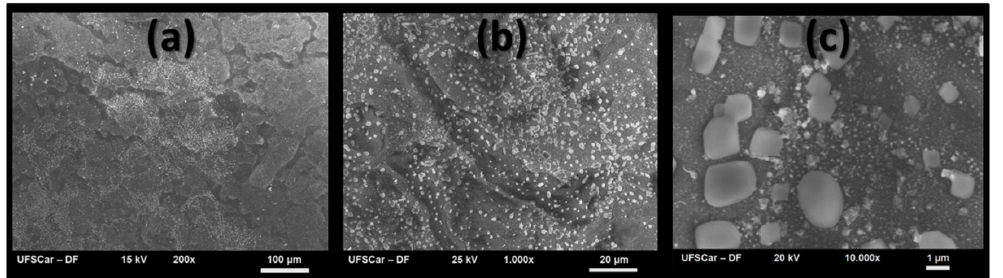
Figure 3. Scanning electron microscopy images show films with extended grooves ( a ) and the presence of small silver microcrystallites ( b ) with cubic structure ( c ).